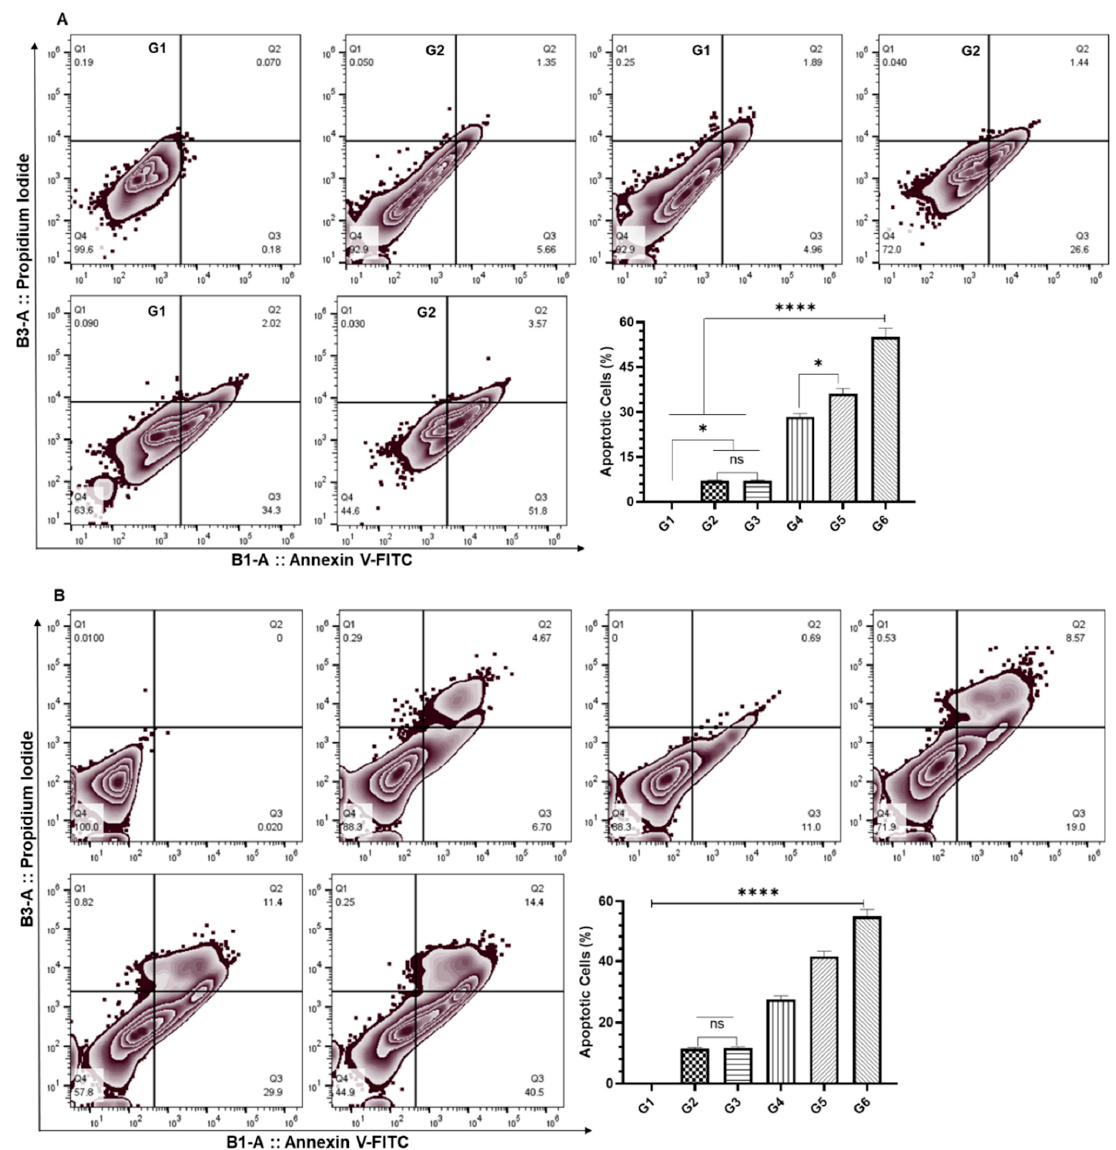
Figure 8. Effect of DCPDD and DCPDO on the induction of apoptosis by flow cytometry in colon cancer cells: ( A ) HCT116 cells; ( B ) RKO cells. The doses of DCPDD were selected as IC 10 and IC 25